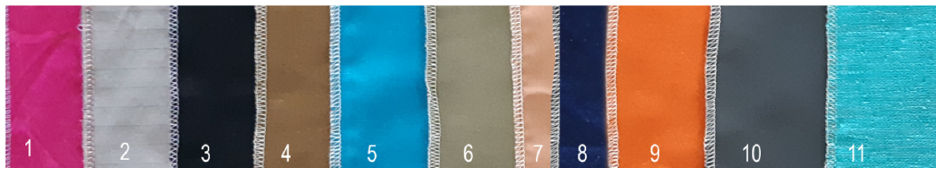
Figure 8. Textile samples of different material composition.